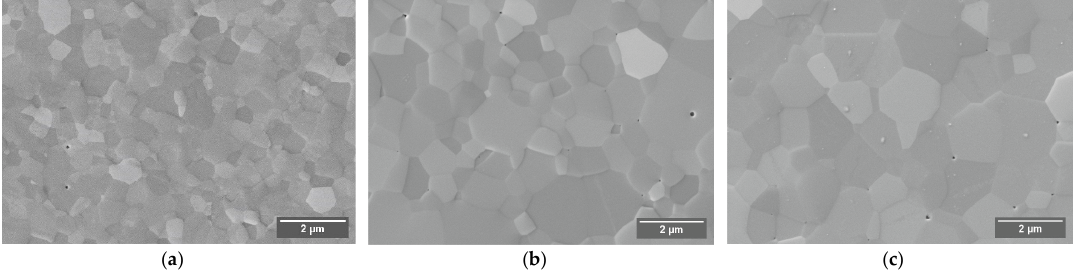
Figure 3. Field emission scanning electron microscopy (FESEM) images of the polished cross section of the sample: ( a ) O1 [6]; ( b ) HT1350; ( c ) HT1400.